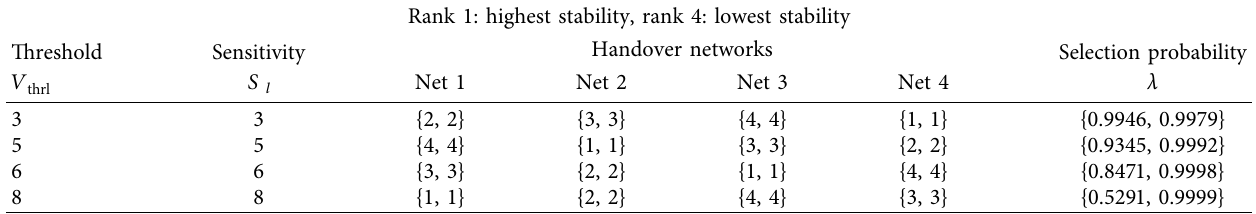
Table 8: Final handover ranking of stable map as a function of both equal threshold and sensitivity values. Rank 1: highest stability, rank 4: lowest stability